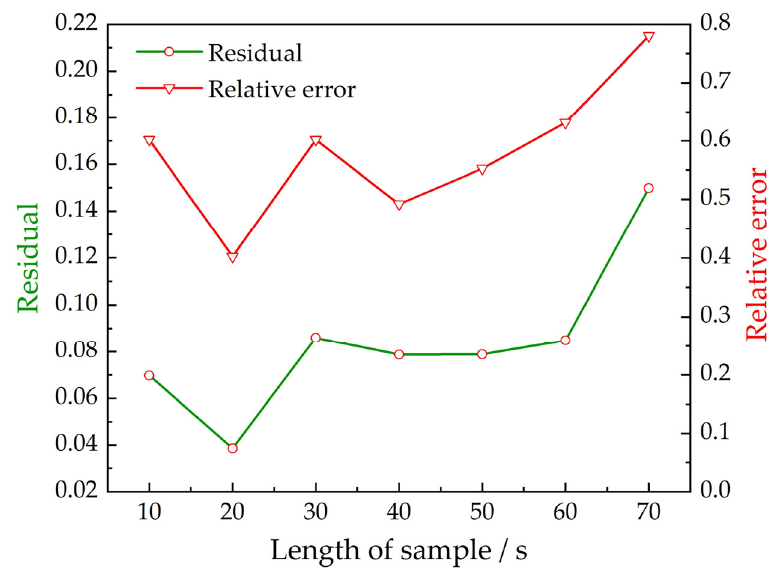
Figure 12. Prediction error vs. the data set length.